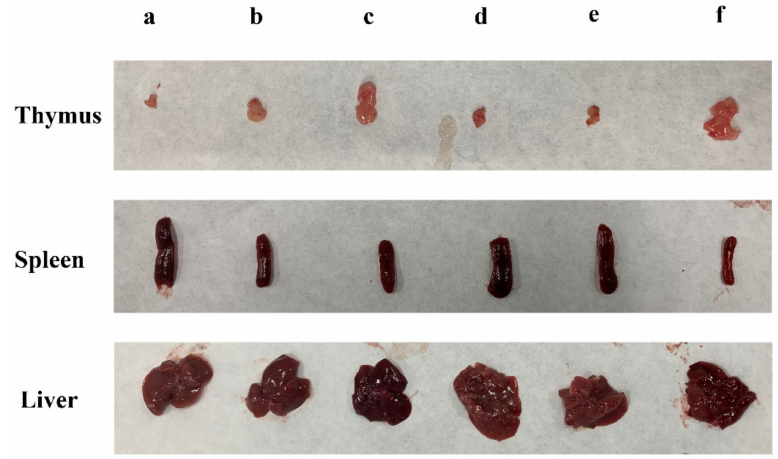
Figure 2. Effects of DLP120 on the immune system organs of H22-bearing mice. ( a ) DLP120 100 mg/kg; ( b ) DLP120 200 mg/kg; ( c ) DLP120 300 mg/kg; ( d ) 5-Fu group; ( e ) model group; ( f ) blank